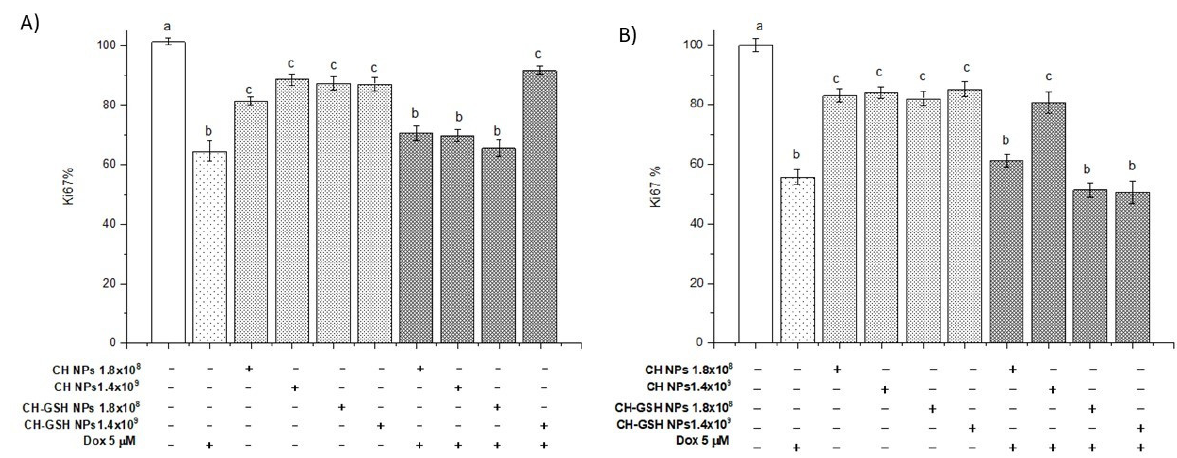
Figure 11. Ki67 levels. The cells were exposed to Dox for 12 h and then 2 h with CH-GSH NPs. ( A ) MCF-7 and ( B ) MDA MB-231 cells. Bars with equal letters indicate no significant differences between the means (Tukey’s test, p <0.05).